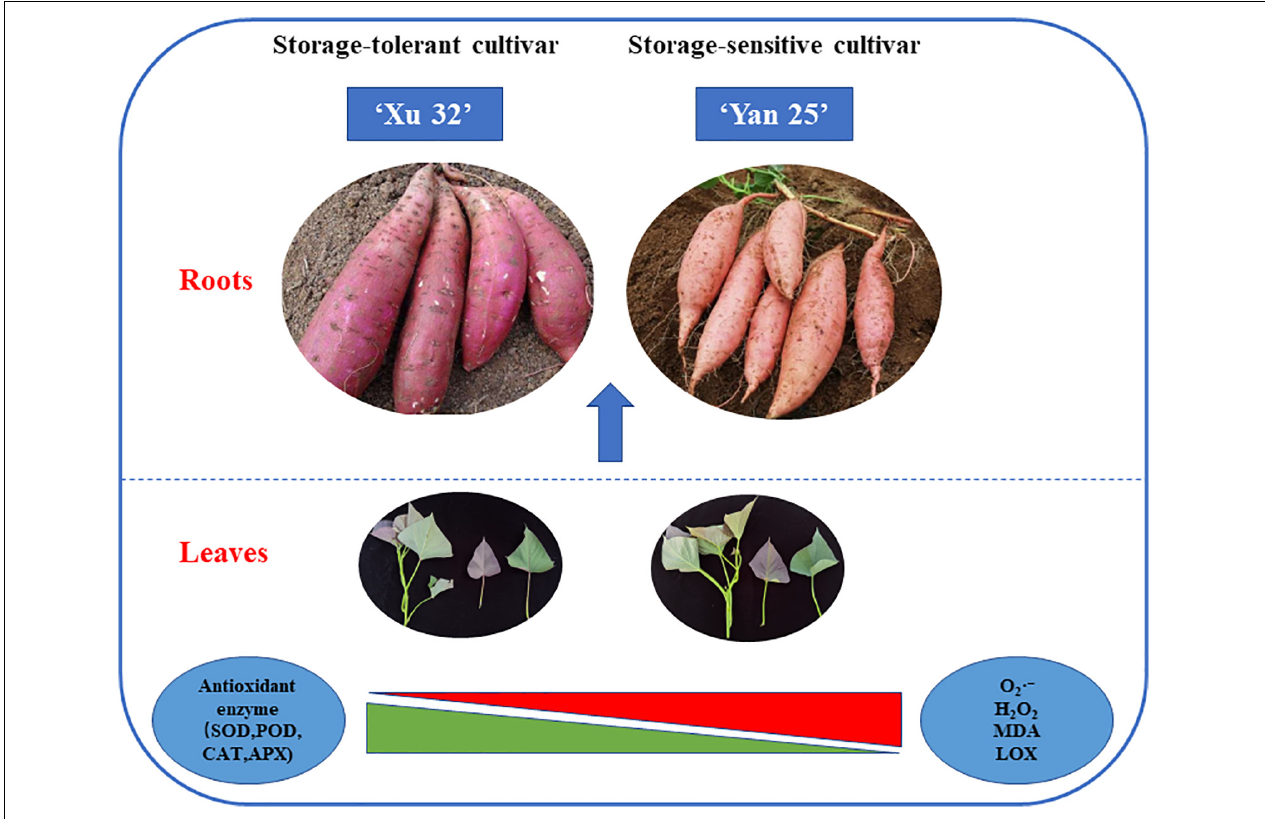
FIGURE 7 | Schematic diagram showing that ROS and MDA levels; LOX, SOD, POD, APX, and CAT activities in sweet potato leaves are highly associated with the storage property of different sweet potato